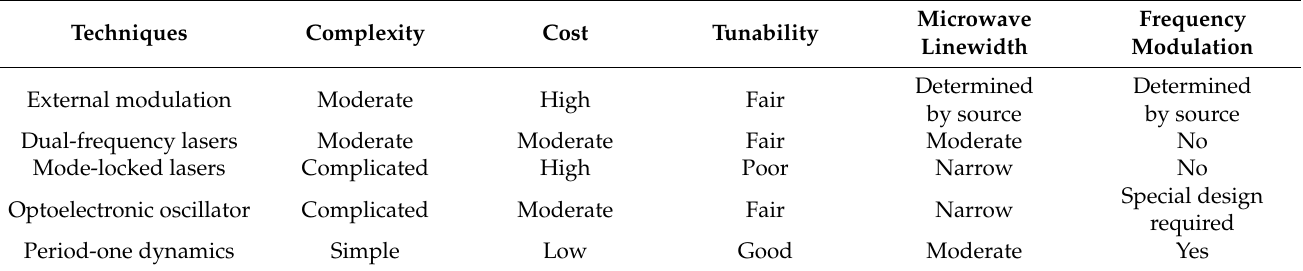
Table 1. Comparison of Photonic Microwave Signal Generation